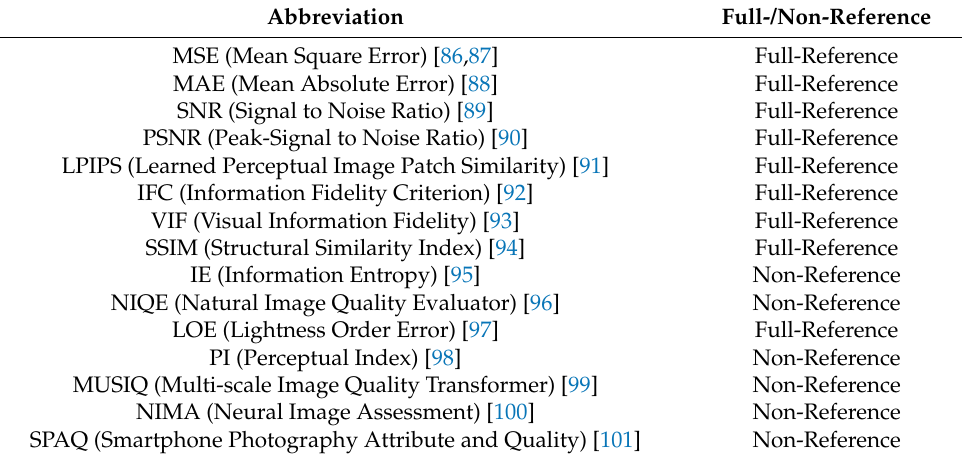
Table 3. Abstract of objective quality evaluation index of the